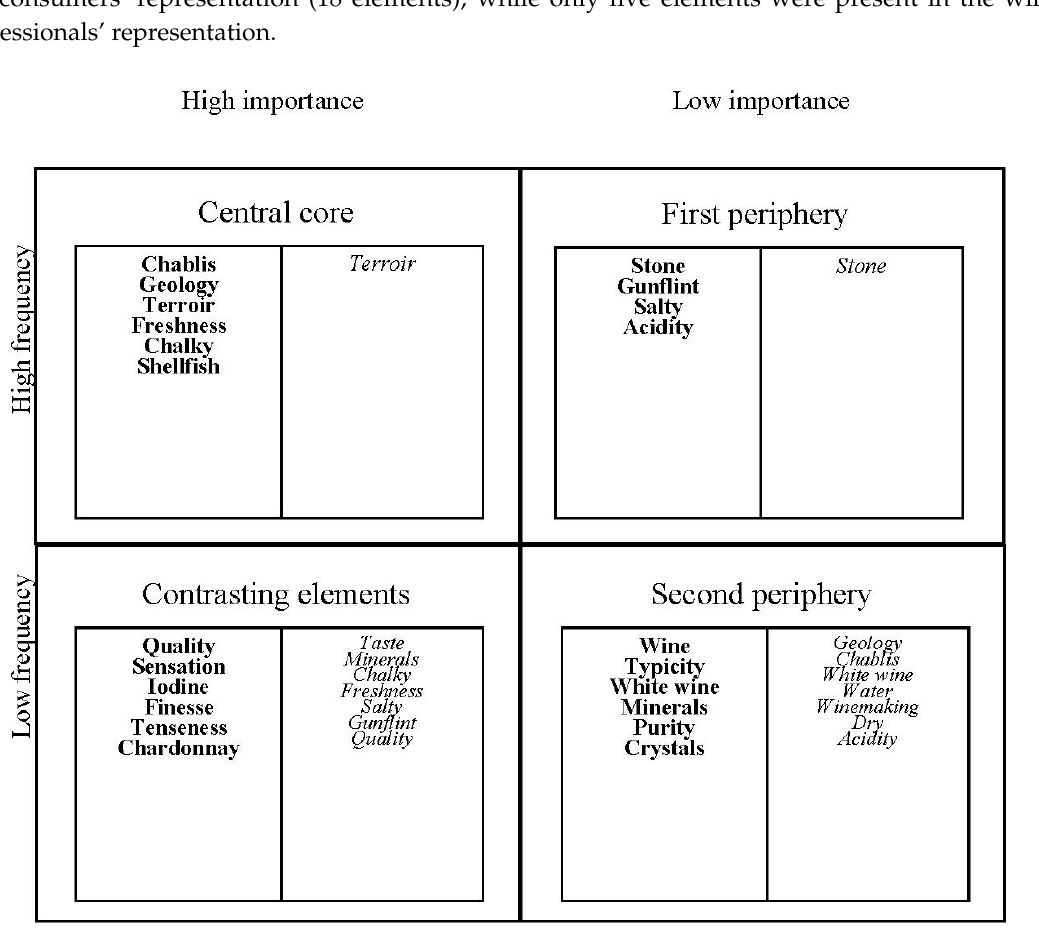
Figure 1. Diagram to exemplify the structure of a social representation according to Abric (1987), with the representational content from Rodrigues et al. (2015): wine producers in bold letters; wine consumers in italics.